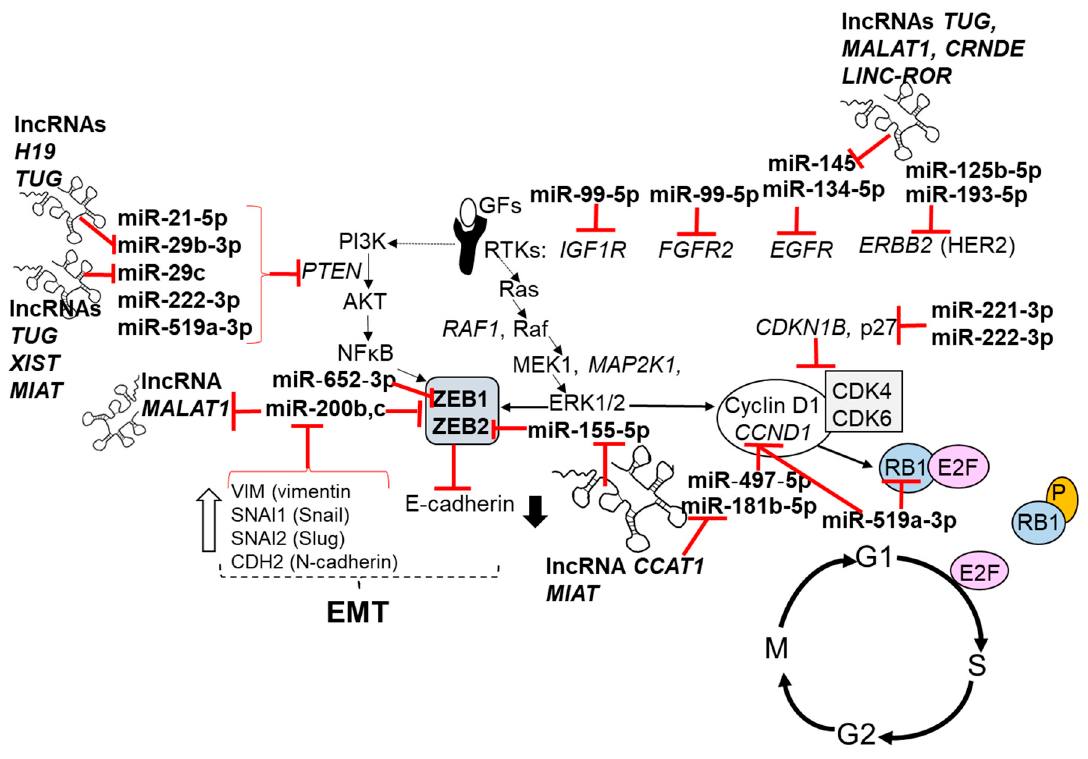
Figure 2. Breast cancer dysregulated miRNAs and lncRNAs as ceRNAs in cell signaling, cell cycle, and EMT. Shown are validated targets of some miRNAs dysregulated in human tumors and lncRNAs that at as ceRNAs for the indicated miRNAs.